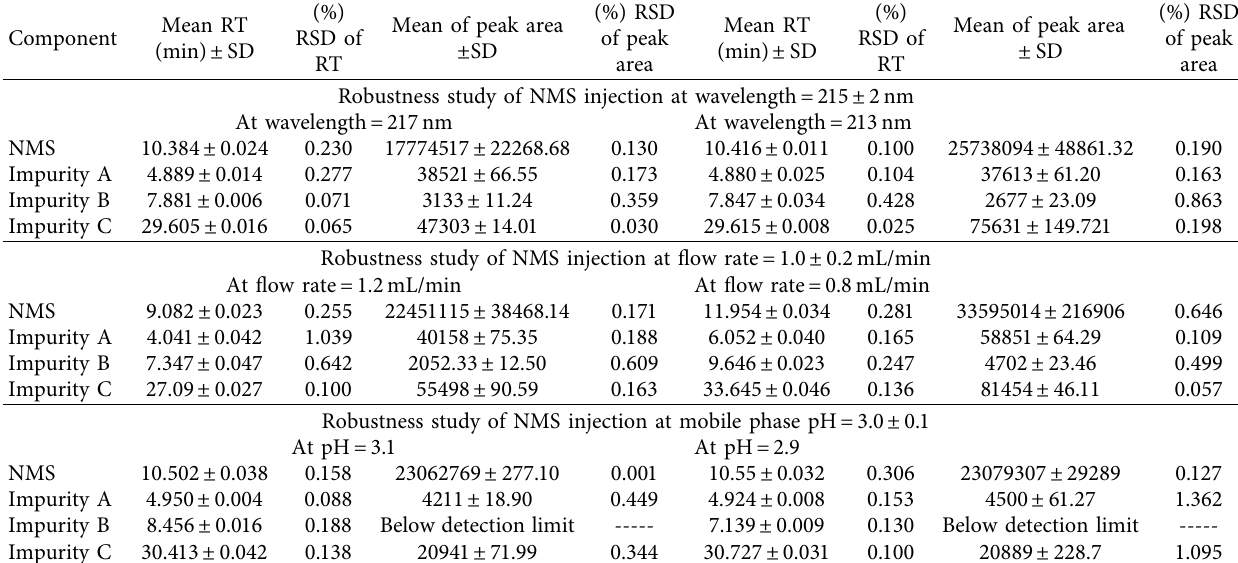
Table 8: Robustness study of NMS